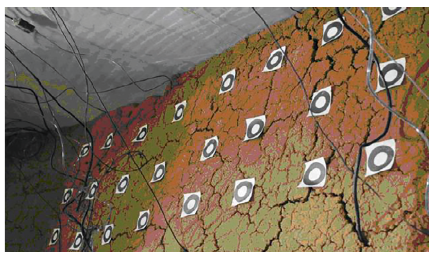
Figure 11: Loess slope surface at the